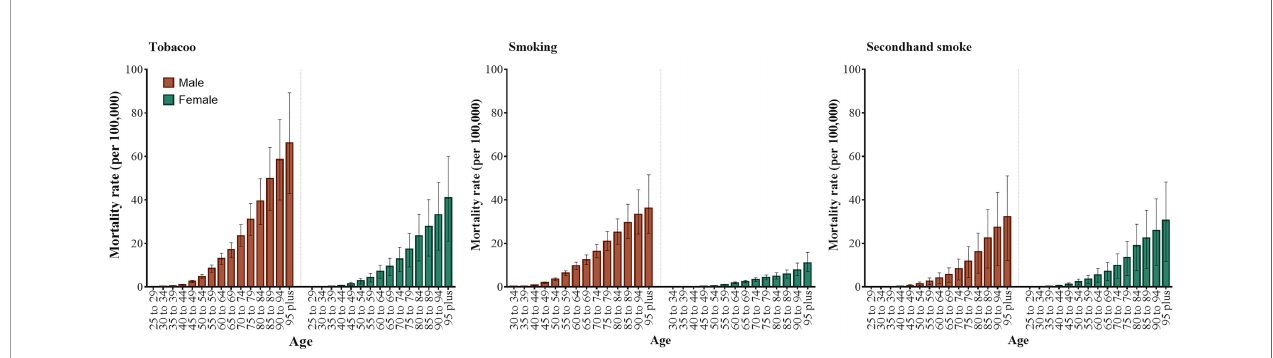
FIGURE 1 | Mortality of T2D attributable to tobacco, smoking, and secondhand smoke by age group and gender. Error bars represent the 95% UIs